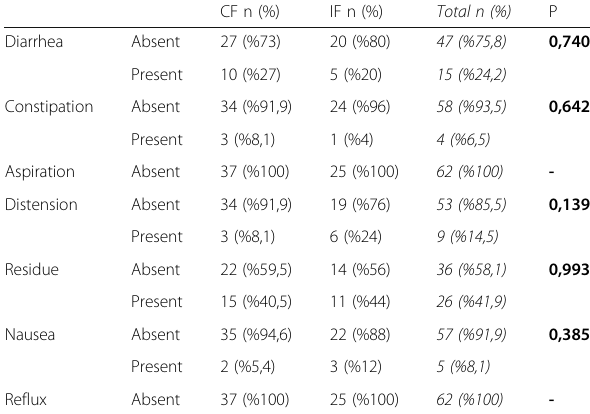
Table 1 (abstract 000788). Evaluation of